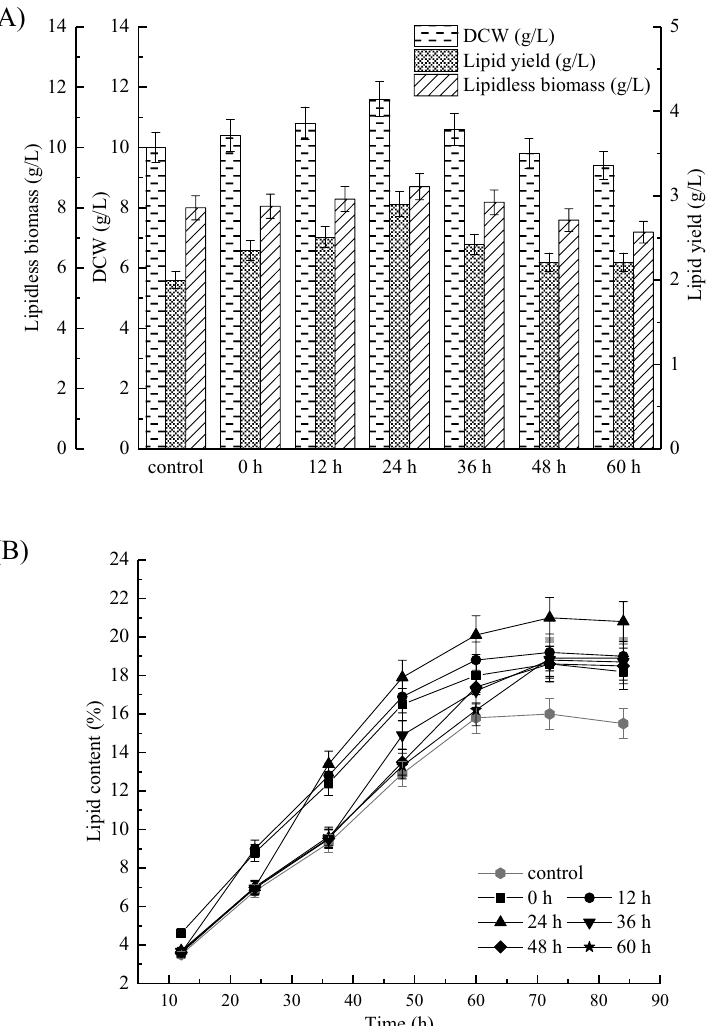
Figure 3. Cell growth and lipid production of Mc-MT-2 as a function of the time when 0.8% malic acid was added to the culture medium. ( A ) Cell growth and lipid yield were measured at the end of batch fermentation when malic acid was added to the culture medium at 0, 12, 24, 36, 48 or 60 h respectively after inoculation. ( B ) Time course of lipid content with the addition of 0.8% malic acid at different times after inoculation. Values were mean of three independent fermentation experiments. Error bars represent the standard error of the